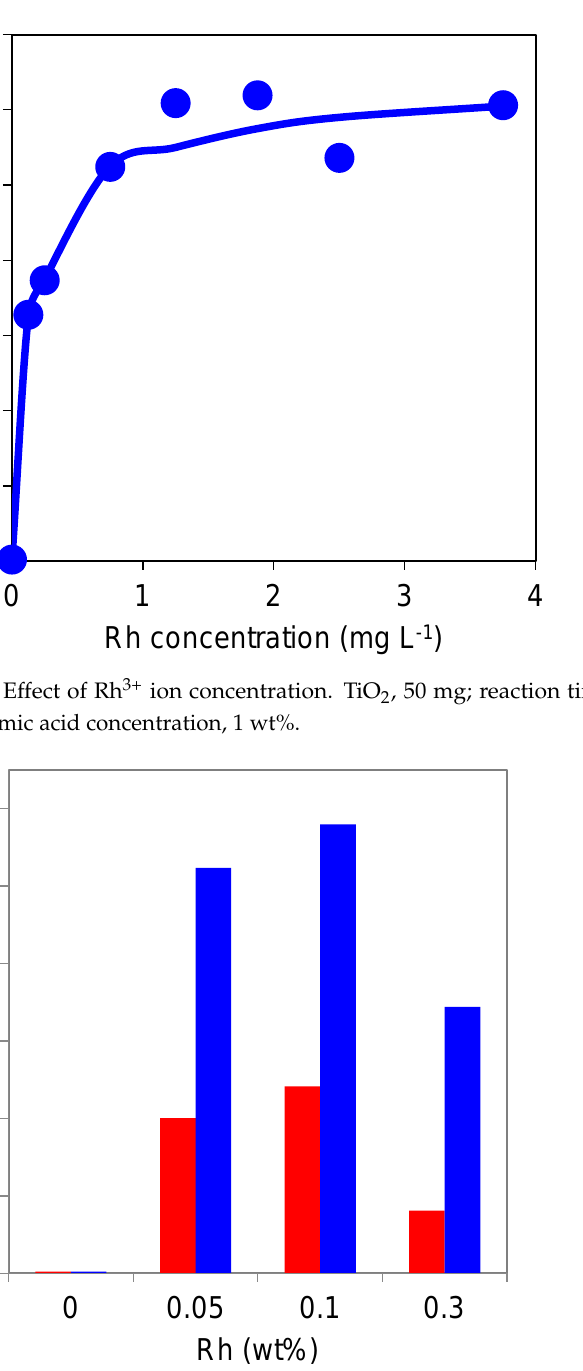
Figure 2. Comparison of the activity for the simultaneous photo-deposition of Rh in TiO 2 (blue) with the prepared Rh/TiO 2 (red). TiO 2 , 50 mg; Rh, 1.25 ppm; reaction time, 3 h; reaction temperature, 50 ◦ C; formic acid concentration, 1